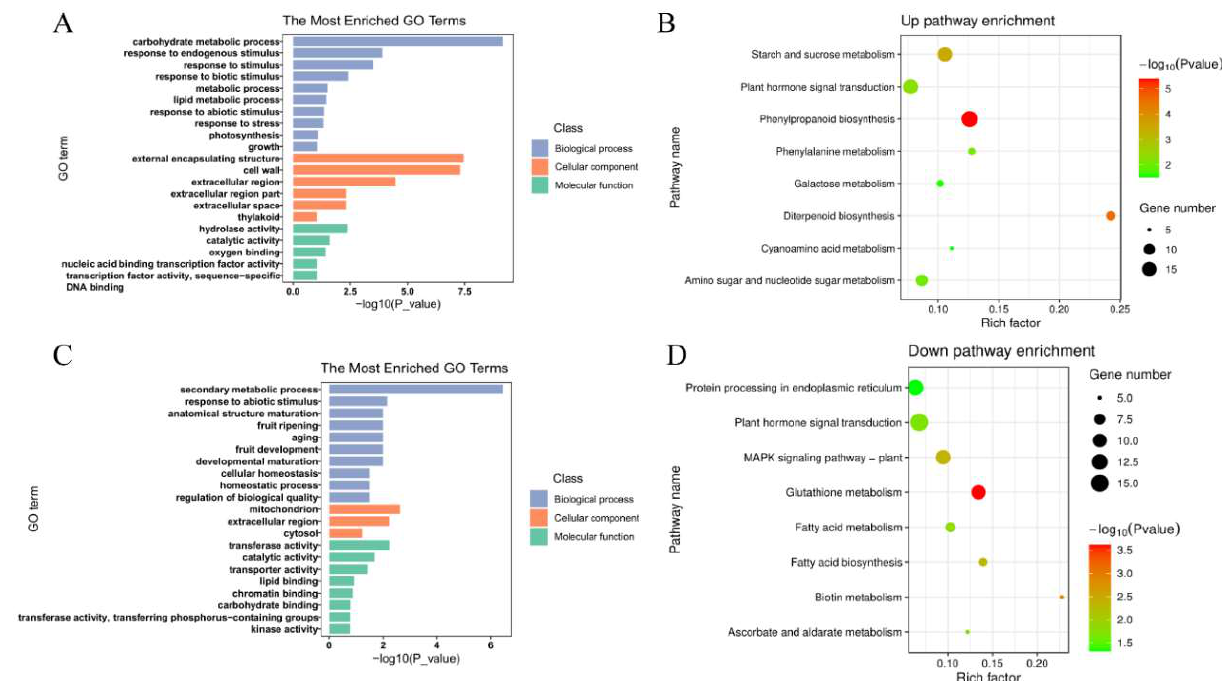
Figure 4. Transcriptomic analysis of ZH11and AcWRKY31-OE transgenic rice plants. ( A ) GO analysis of the upregulated genes. ( B ) KEGG pathway analysis for upregulated genes. ( C ) GO analysis of the downregulated genes. ( D ) KEGG pathway analysis for downregulated genes.